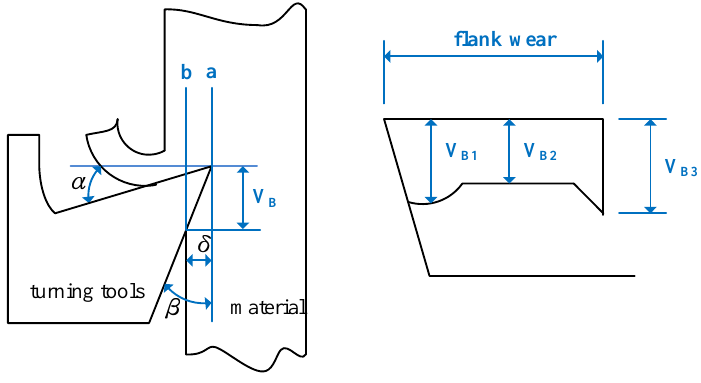
Figure 7. Measurement of tool frank wear.